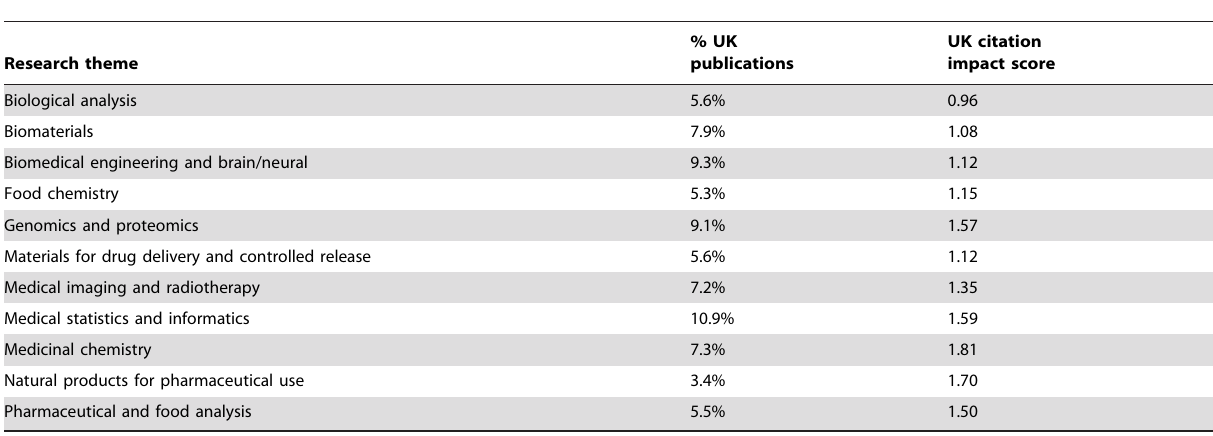
Table 6. Contribution of the UK to the 11 research themes at the EPS-HLS